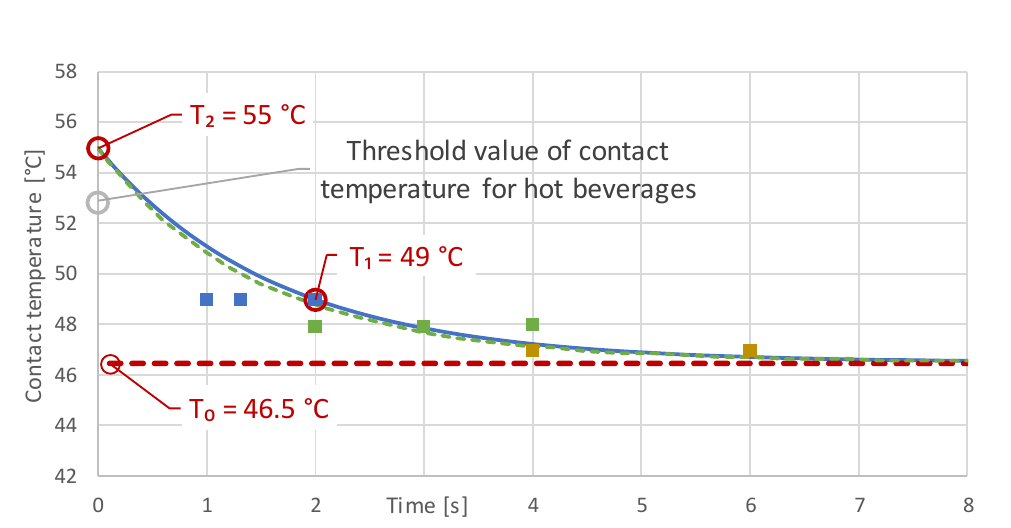
Figure 9. Measured value pairs and interpolation by an exponential function (Equation (4)). The value pairs used to calculate the constants k (<0) and a as grid points are circled in red and the course of the function is shown as a solid blue curve. The green dashed curve represents the average of all functions approximated with the measured values. For comparison, the contact temperature 52.9 ◦ C calculated from the threshold value for hot beverages 65 ◦ C at t = 0 is entered and marked as a grey circle. It is significantly higher than the measured value T 0 = 46.5 ◦ C for solid foods.